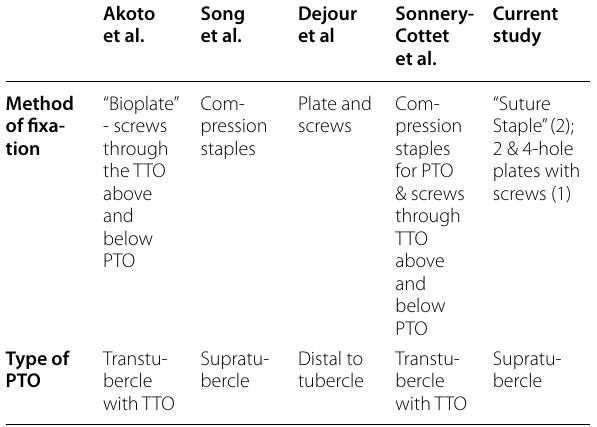
WBAT Weight Bearing as Tolerated